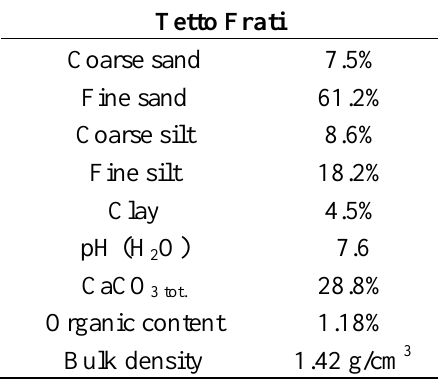
Table 2. Chemical and physical characteristics of the soil used in this work.